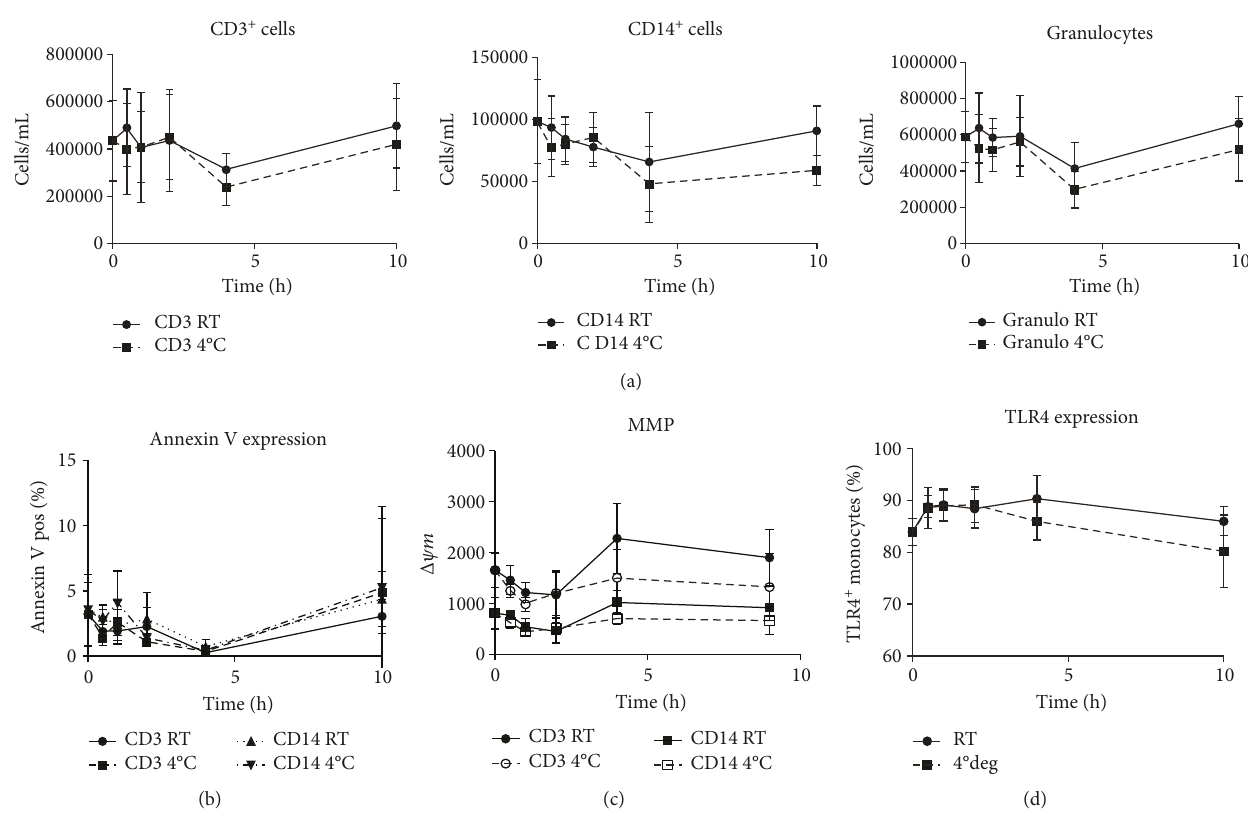
Figure 2: Cell viability (cell counts, annexin V, and MMP) and TLR4 expression in whole blood cultures (average plus SD). In whole blood cultures of 6 donors, absolute cell counts (T-cell, monocyte and granulocyte numbers (a)), apoptosis (annexin V-positive T-cells and monocytes (b)), mitochondrial function (MMP for T-cells and monocytes (c)), and TLR4 expression (TLR4-positive monocytes (d)) were quanti fi ed. The x -axis indicates the sample age (time span between blood collection and start incubation). The blood was stored at room temperature (continuous lines) or 4 ° C (dashed